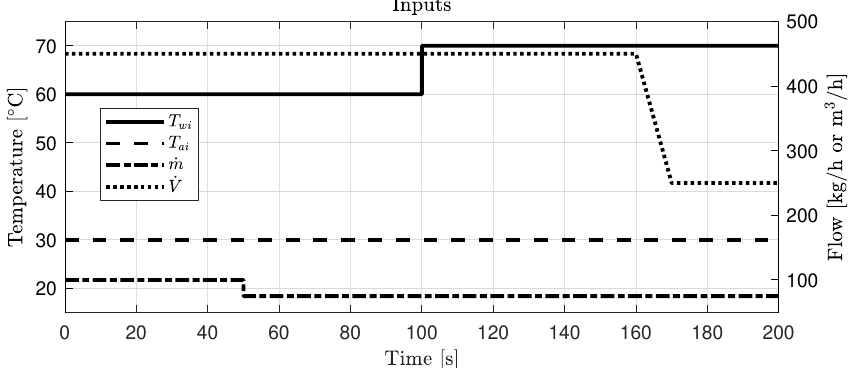
Figure 4. Time sequence of inlet water temperature T w,in , inlet air temperature T a,in , water mass flow ˙ m and air volumetric flow ˙ V